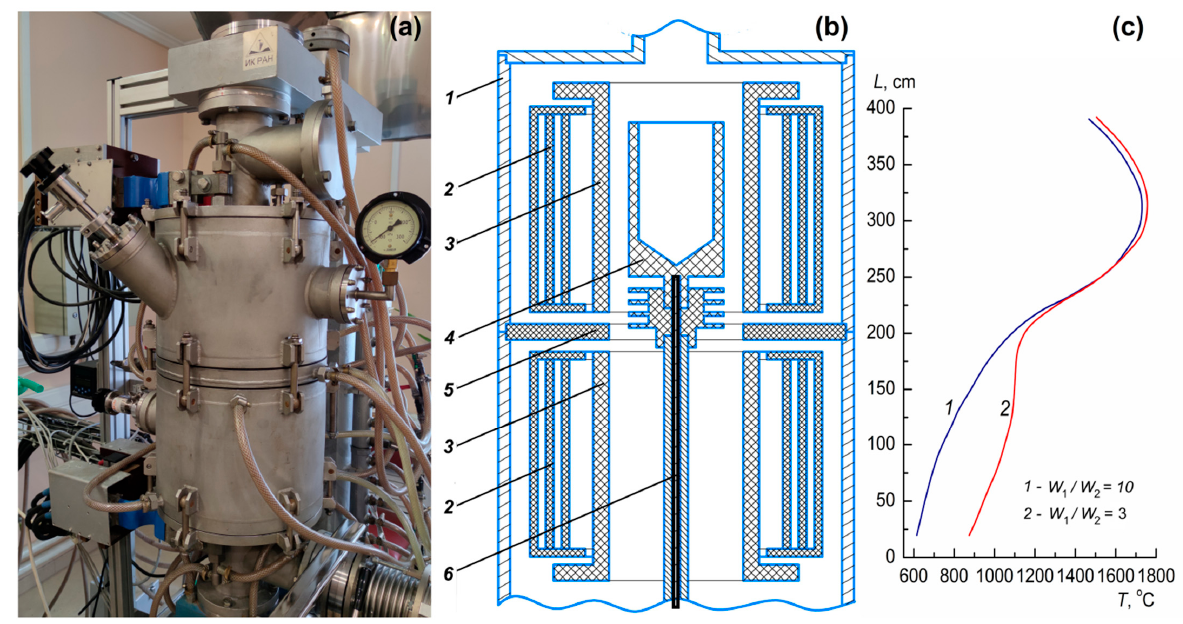
Figure 1. The external view of the two-section growth facility ( a ); a simplified design of the furnace heating unit: 1—water- cooled chamber shell; 2—independent blocks of the radiation thermal screens (graphite/ carbon felt); 3—upper and lower resistance heaters; 4—graphite crucible; 5—graphite (molybdenum) diaphragm; 6—pulling rod with crucible supporting holder and inner W/Re thermocouple ( b ) and axial temperature distribution along the growth chamber length at the different electric power ratios of the upper (W 1 ) and lower (W 2 ) resistance heaters ( c ).